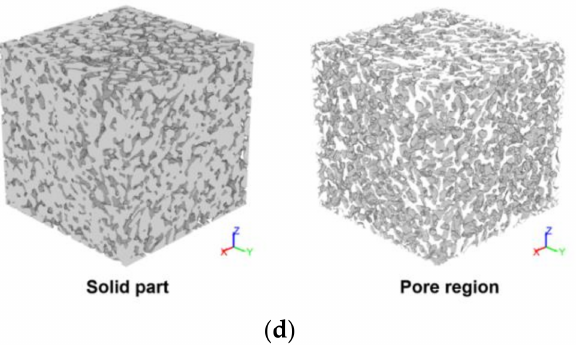
Figure 8. Segmented images of each specimen: ( a ) G33, ( b ) G47, ( c ) G60, and ( d ) G72 (note: in each figure, the solid part is on the left, and the image on the right represents the pore region of the specimen).